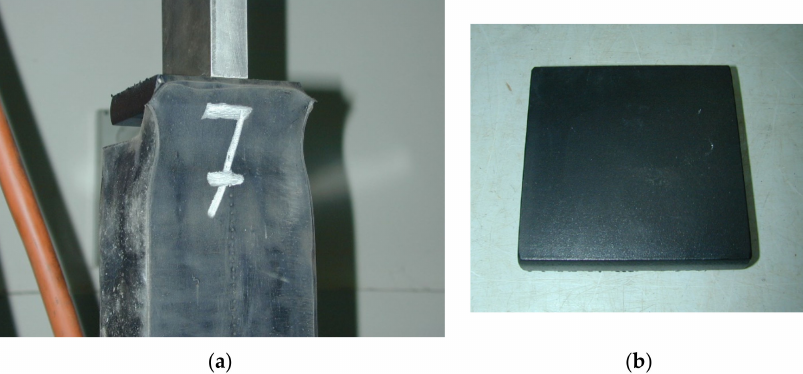
Figure 5. Sample 7 ( a ) at failure; ( b ) after adhesive